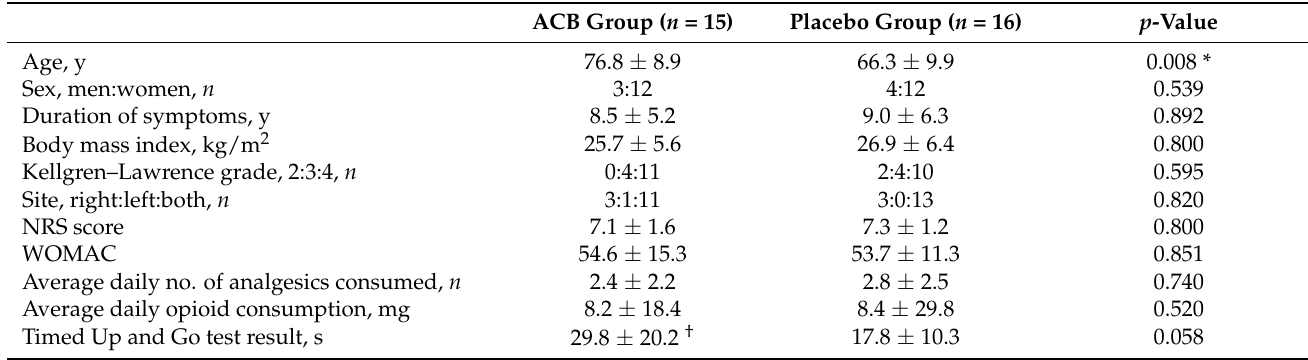
Figure 1. CONSORT flow diagram showing the progress of participants. ACB = adductor canal block. Table 1. Participants’ baseline